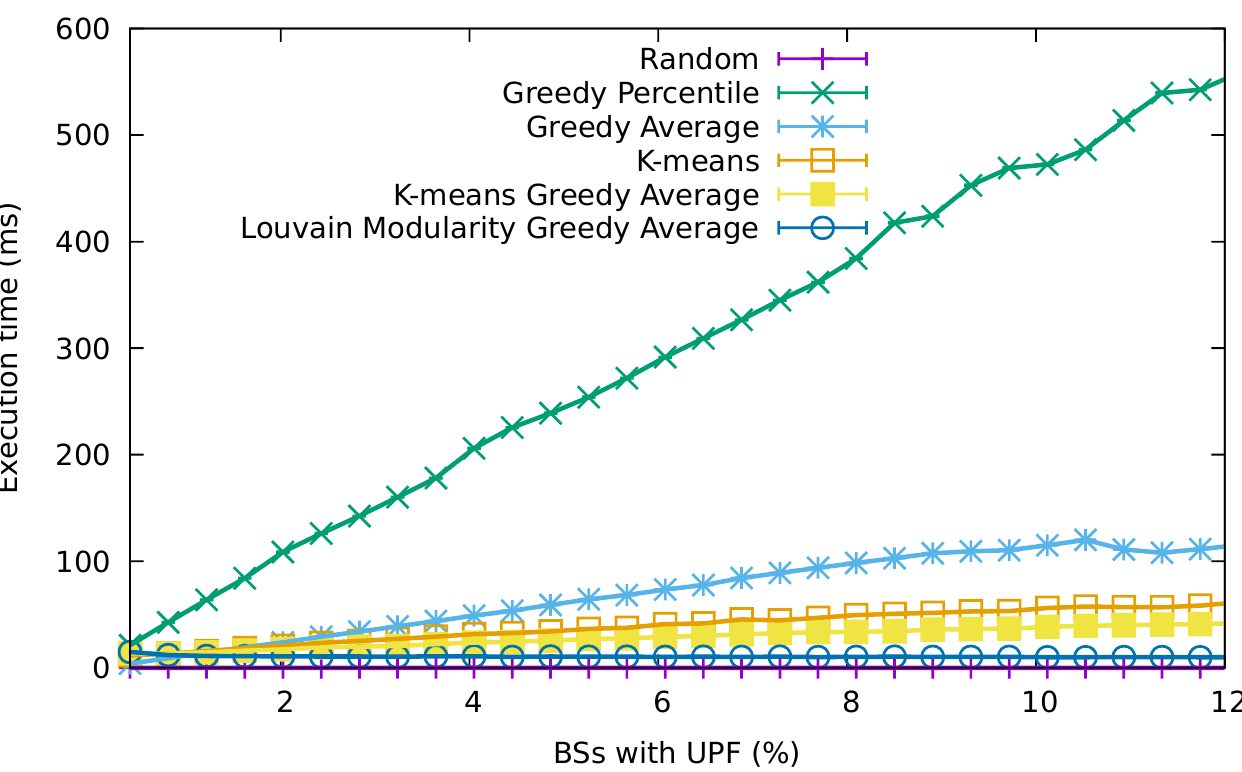
Figure 8. Average execution time for the different algorithms for a growing percentage of base stations containing a